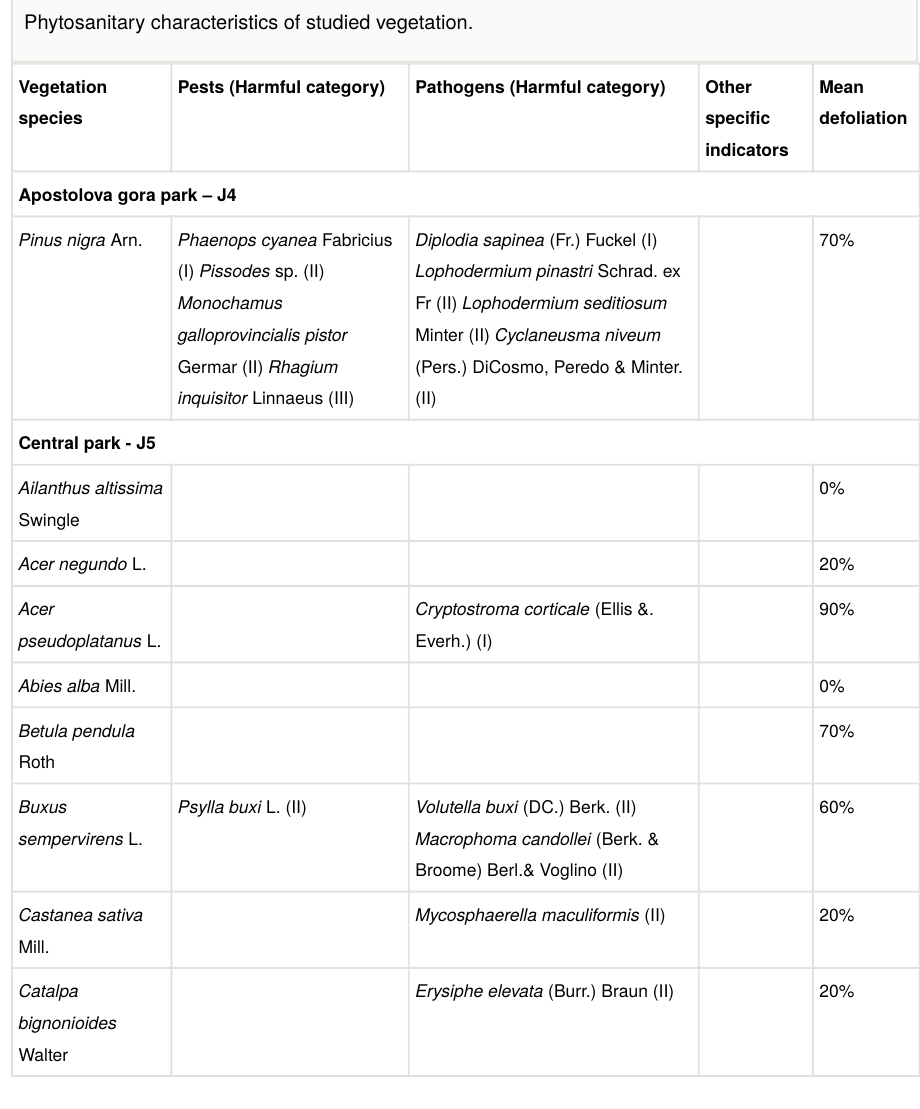
Table 4. Phytosanitary characteristics of studied